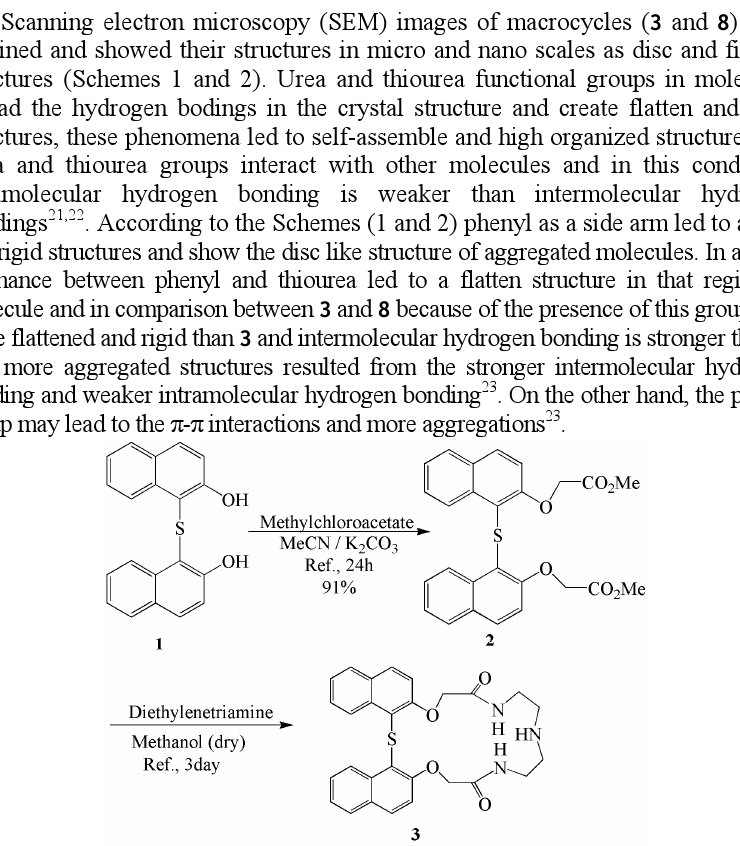
Figure 1. SEM images of